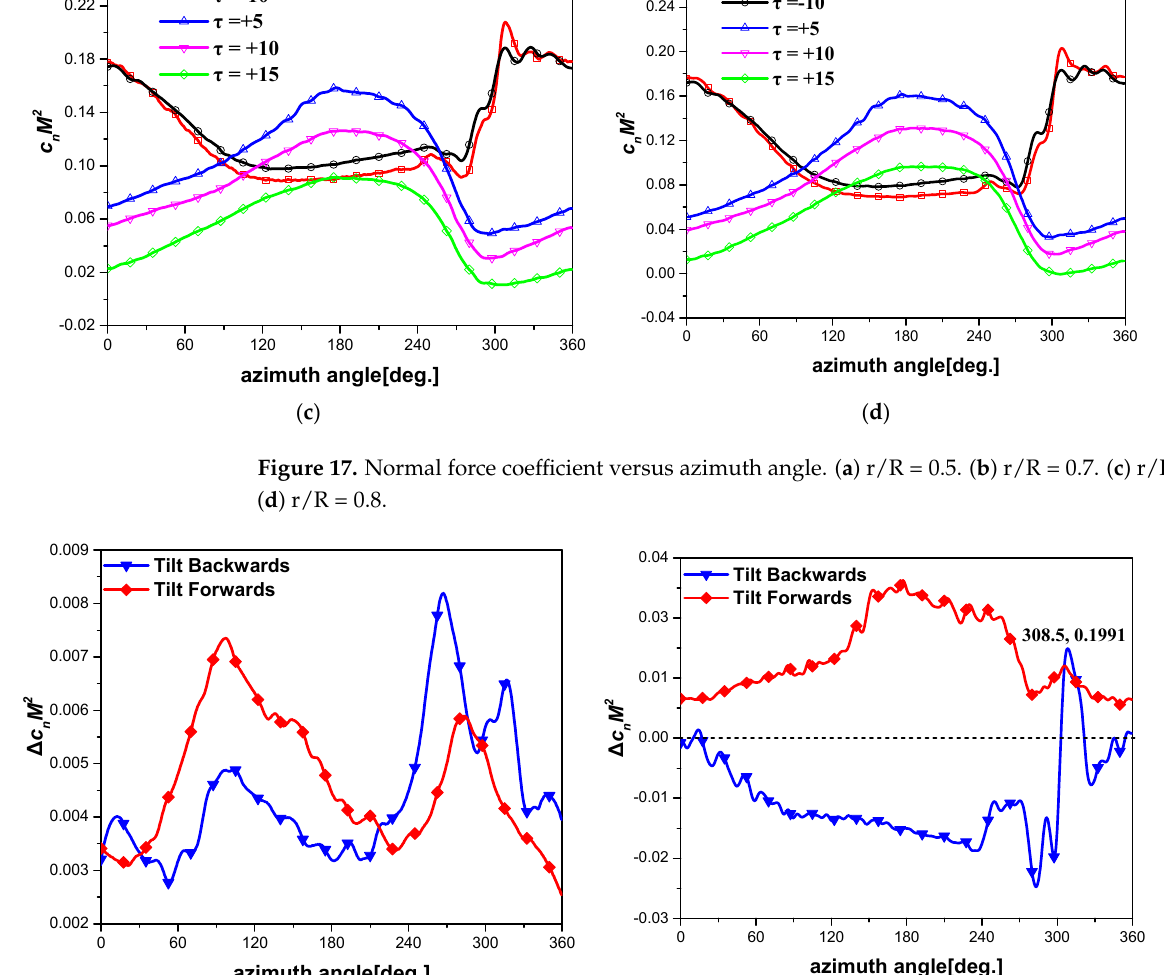
Figure 18. Difference in the normal force coefficient from an absolute tilt angle of 5 ◦ to 10 ◦ . ( a ) r/R = 0.5. ( b ) r/R =